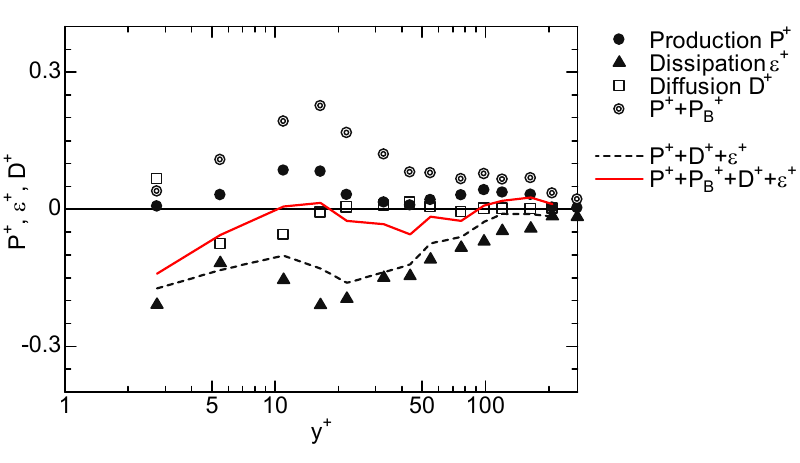
Fig. 19 TKE budgets in single-phase and bubbly flows